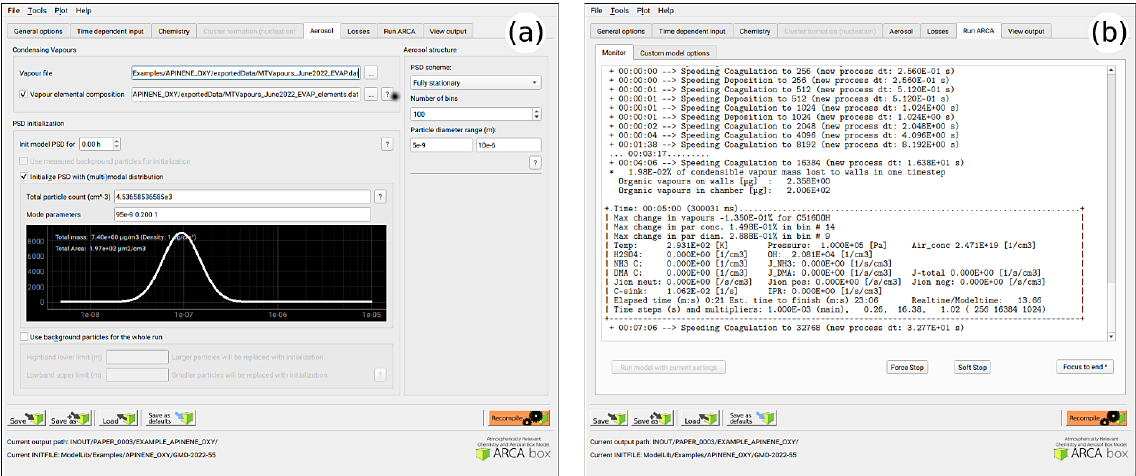
Figure 7. Options related to the discrete aerosol module; selection of PSD scheme, number of bins and the size range, and the parametric initial particle size distribution (a) , as well as example of the model run-time output (b) . The model can be stopped any time forcefully (“force stop”) or gracefully (“soft stop”), in which the latter saves the output gathered so